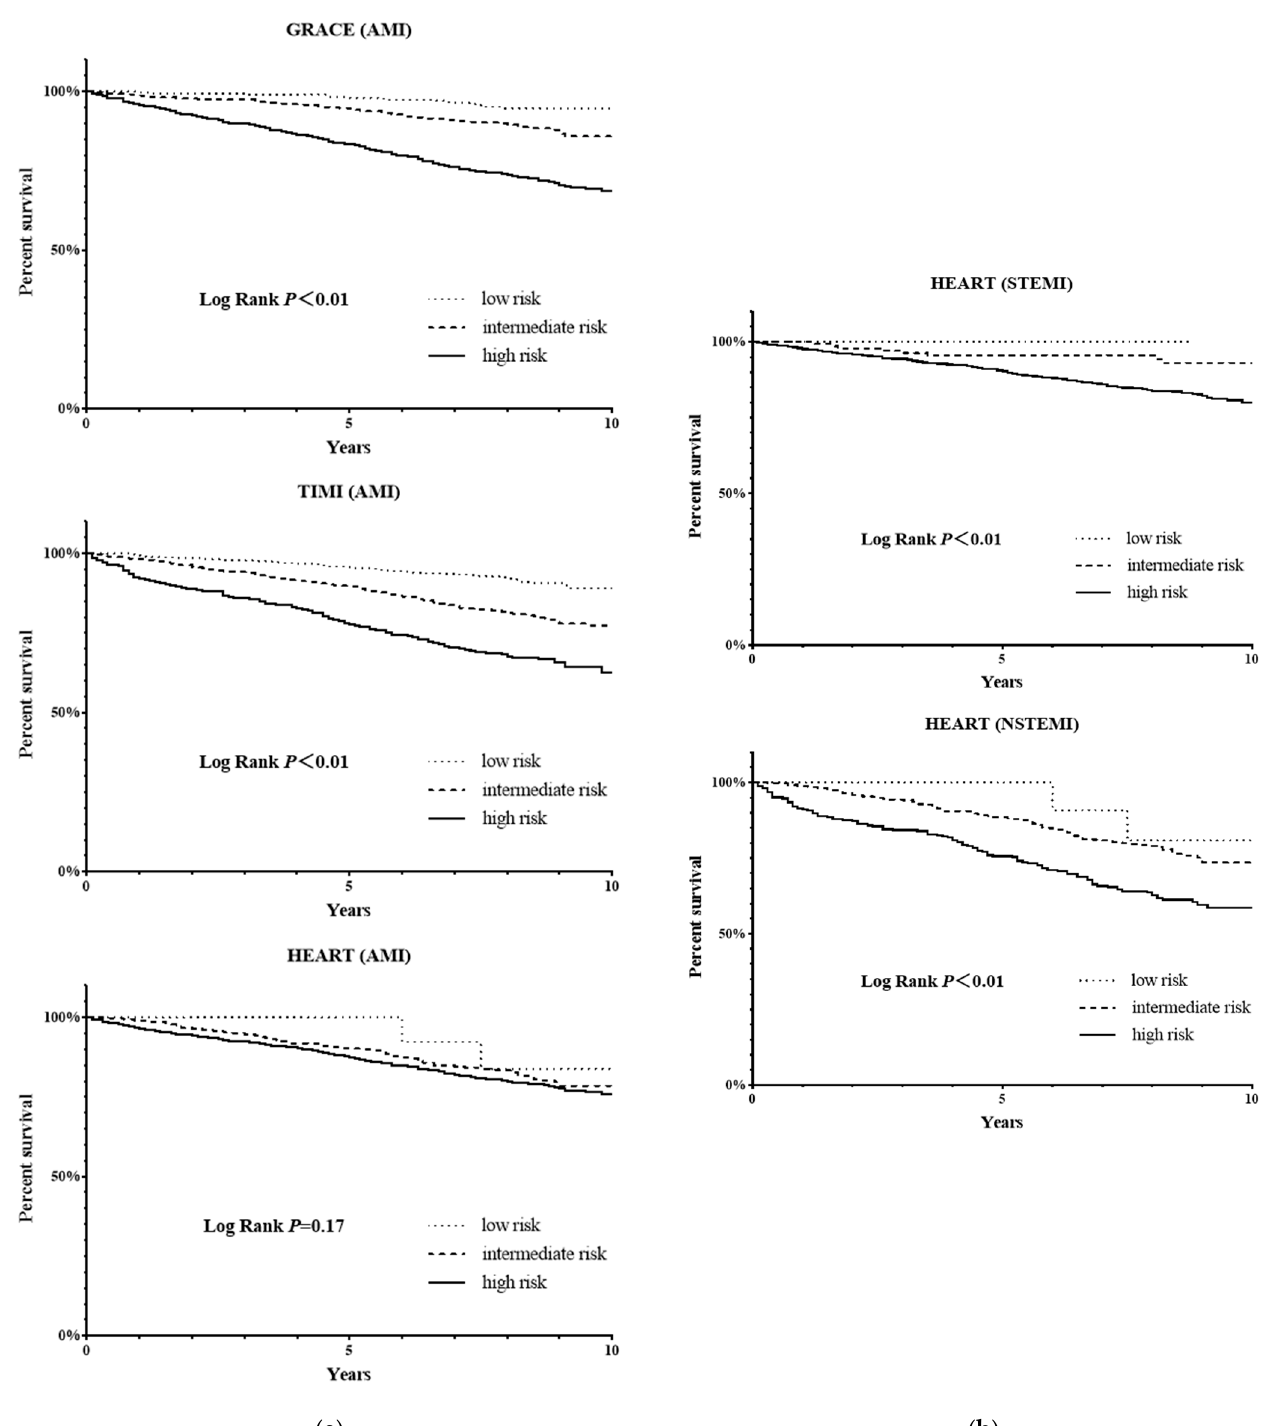
Figure 4. ( a ) Kaplan–Meier survival curves for AMI patients in three risk scores. ( b ) Kaplan–Meier survival curves in patients with STEMI or NSTEMI in the HEART score.